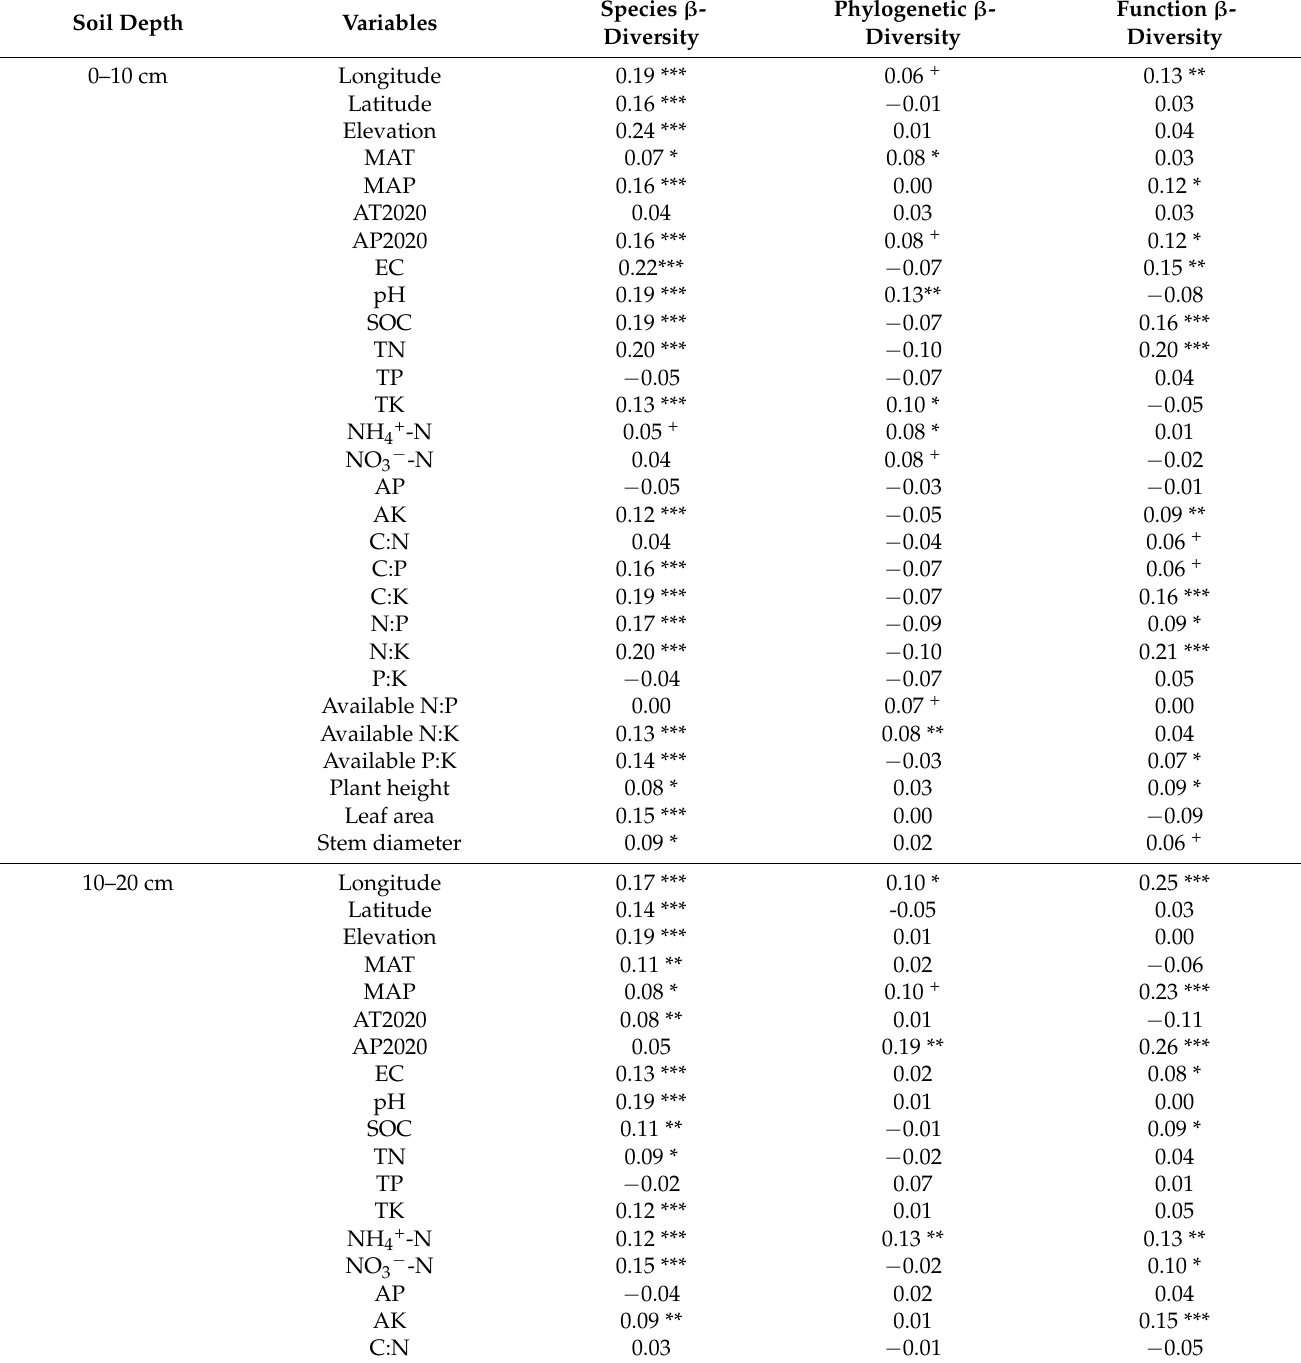
Table 1. Partial mantel tests between β -diversity and environmental